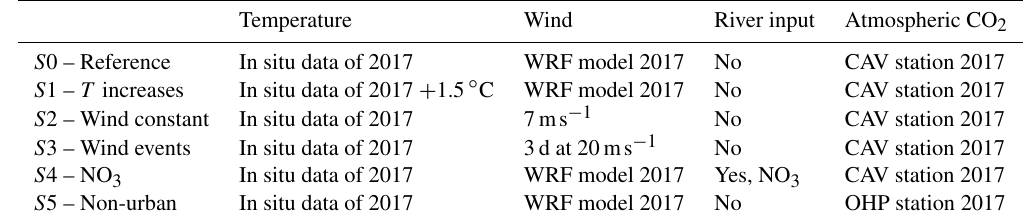
Table 1. Forcing of the different scenarios ( S ) simulated with the model. See Sect. 2.4 for details of the